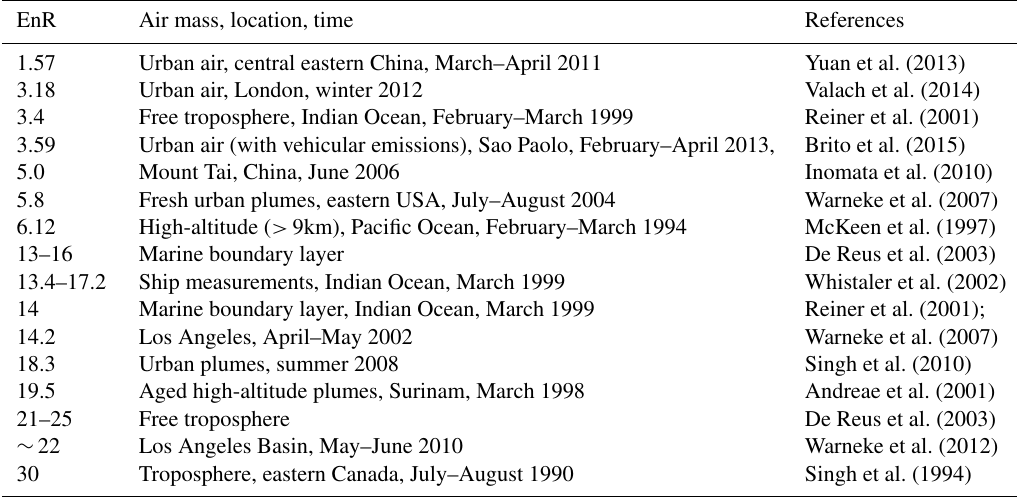
Table 3. Literature values of acetone–CO enhancement ratios (EnRs) in air masses unaffected by biomass burning in pptppb − 1 .